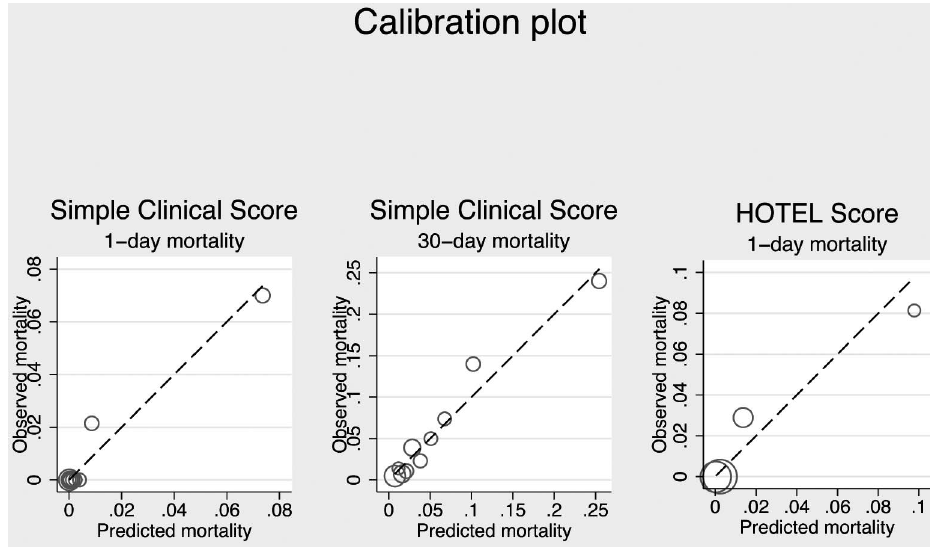
Figure 2. Pearson Correlation test plot.